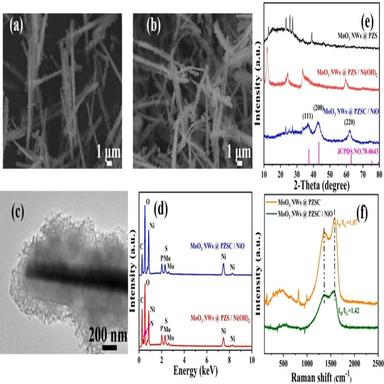
SEM of (a) MoO3 NWs @ PZS / Ni(OH)2 and (b) MoO3 NWs @ PZSC / NiO. (c) TEM of MoO3 NWs @ PZS / Ni(OH)2. (d) EDS of MoO3 NWs @ PZSC / NiO and MoO3 NWs @ PZS / Ni(OH)2. (e) XRD of MoO3 NWs @ PZSC / NiO, MoO3 NWs @ PZS / Ni(OH)2 and MoO3 NWs @ PZS. (f) Raman spectra of MoO3 NWs @ PZSC / NiO and MoO3 NWs @ PZSC.